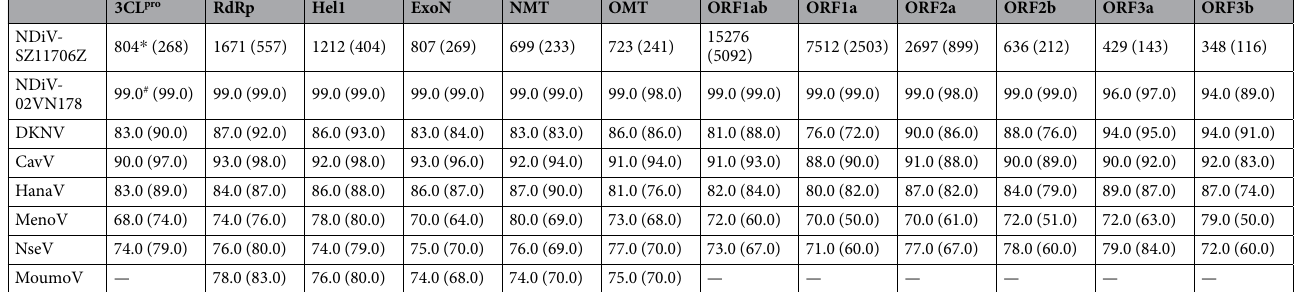
Table 1. Comparison of six critical replicase domains and the complete ORFs of NDiV-SZ11706Z with those of other mesoniviruses. * Nucleotide number (amino acid number); # percent nucleotide sequence homology (amino acid sequence homology).